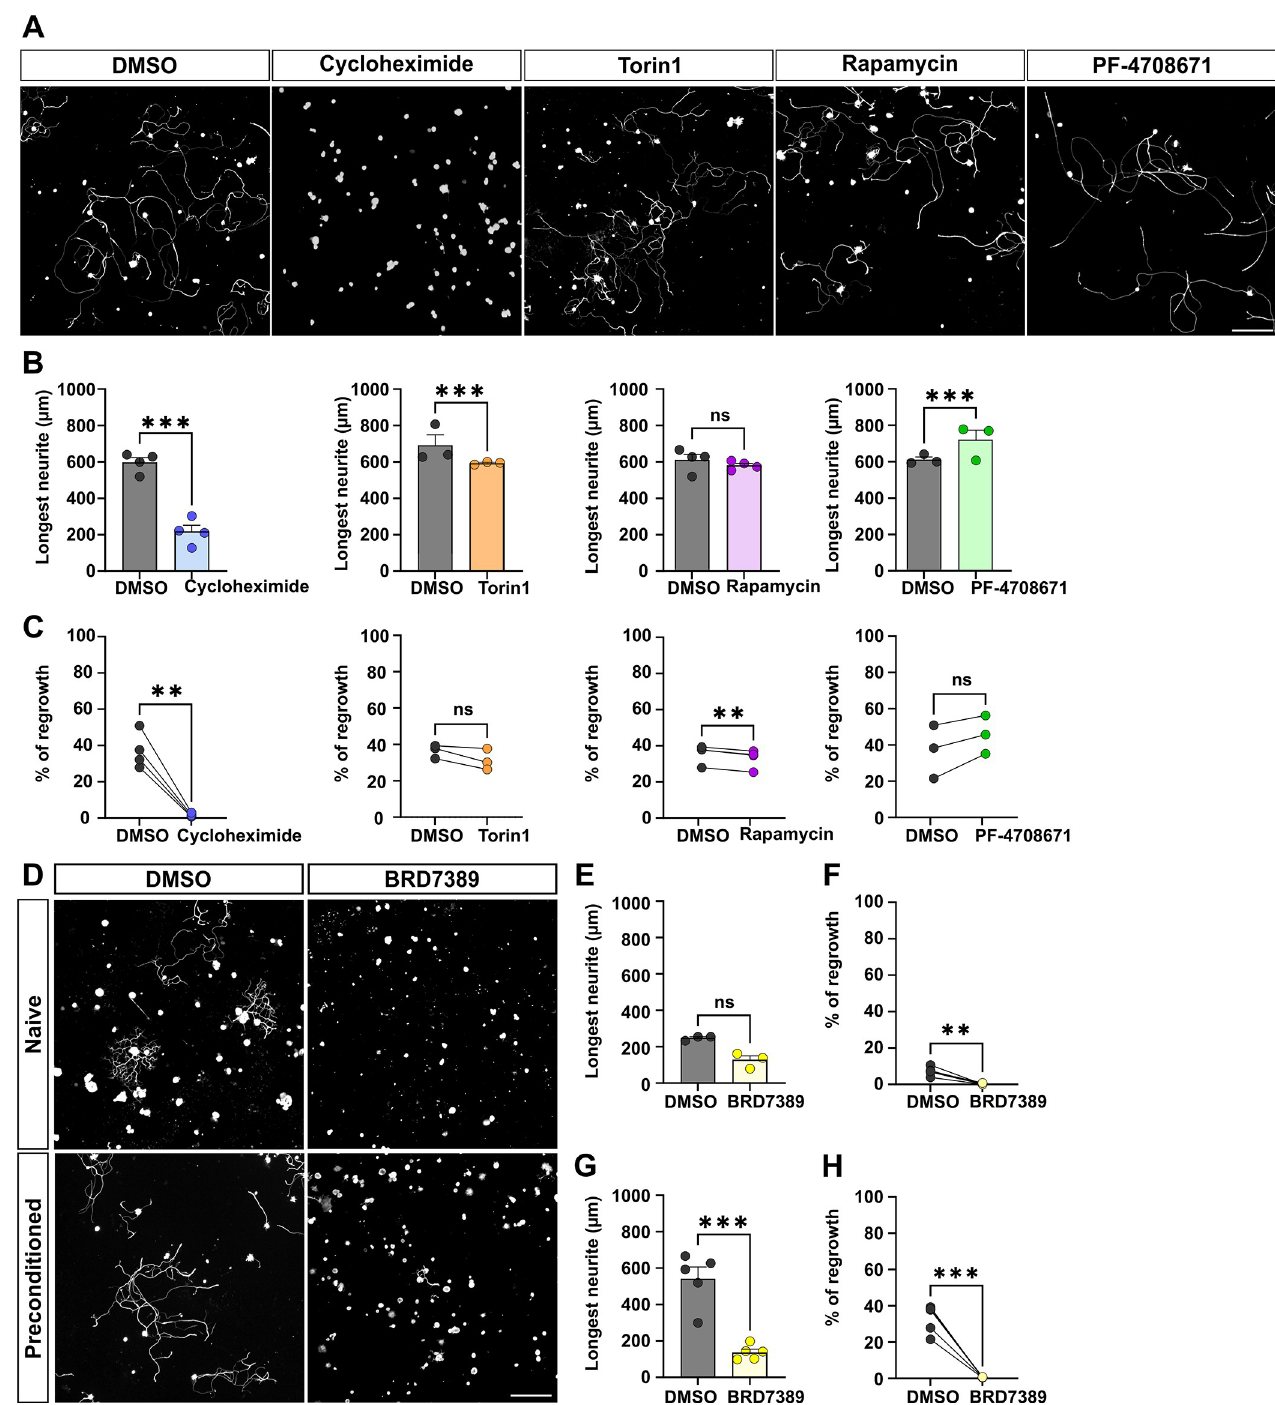
Fig 3. RSK controls the preconditioning effect in mature DRG neurons. (A) Representative microphotographs of preconditioned cultures of mature DRG neurons treated with DMSO (control), translation inhibitor (Cycloheximide, 2 nM), mTOR inhibitors (Torin1, 5 nM or Rapamycin, 0.1 nM), S6K1 inhibitor (PF-4708671-8uM). Scale bar: 250 μ m. (B) Quantification of longest neurite length per neuron 16 h after plating (mean ± SEM, two-way ANOVA, 3–4 independent DRG cultures, approximately 50–100 cells counted per condition per culture (except for Cycloheximide)). (C) Percentage of neurons growing a neurite 16 h after plating (mean ± SEM, two-way ANOVA, 10 random microscopy fields quantified per condition). (D) Representative microphotographs of naive and preconditioned cultures of mature DRG neurons treated with DMSO (control) or RSK inhibitor (BRD-7389 (3 μ m)). Scale bar: 250 μ m. (E) Quantification of longest neurite length per neuron 16 h after plating in naive condition (mean ± SEM, two-way ANOVA, 3 independent DRG cultures,